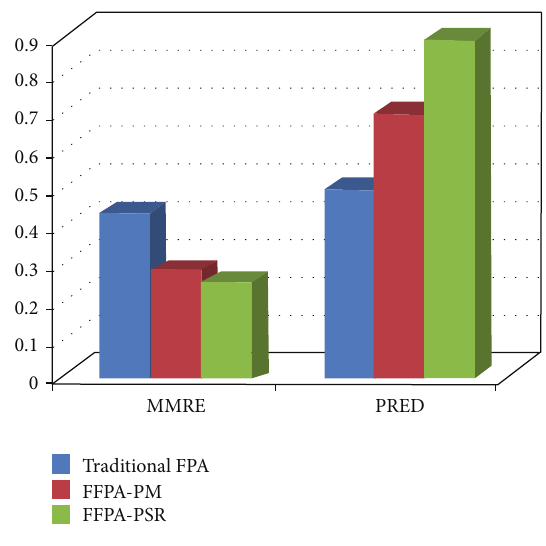
Figure 2: Effort chart. Table 4: Performance comparison.